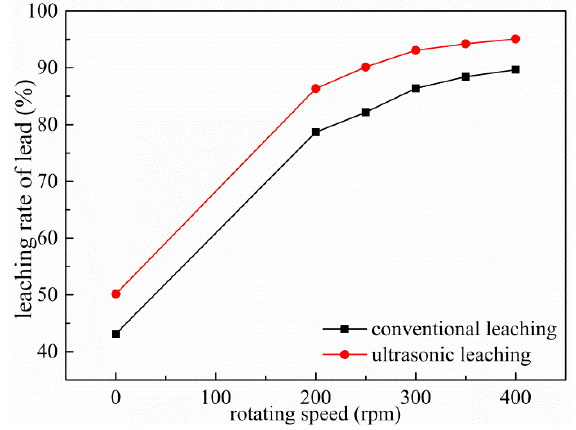
Figure 12. Effects of rotating speed on leaching of Pb.